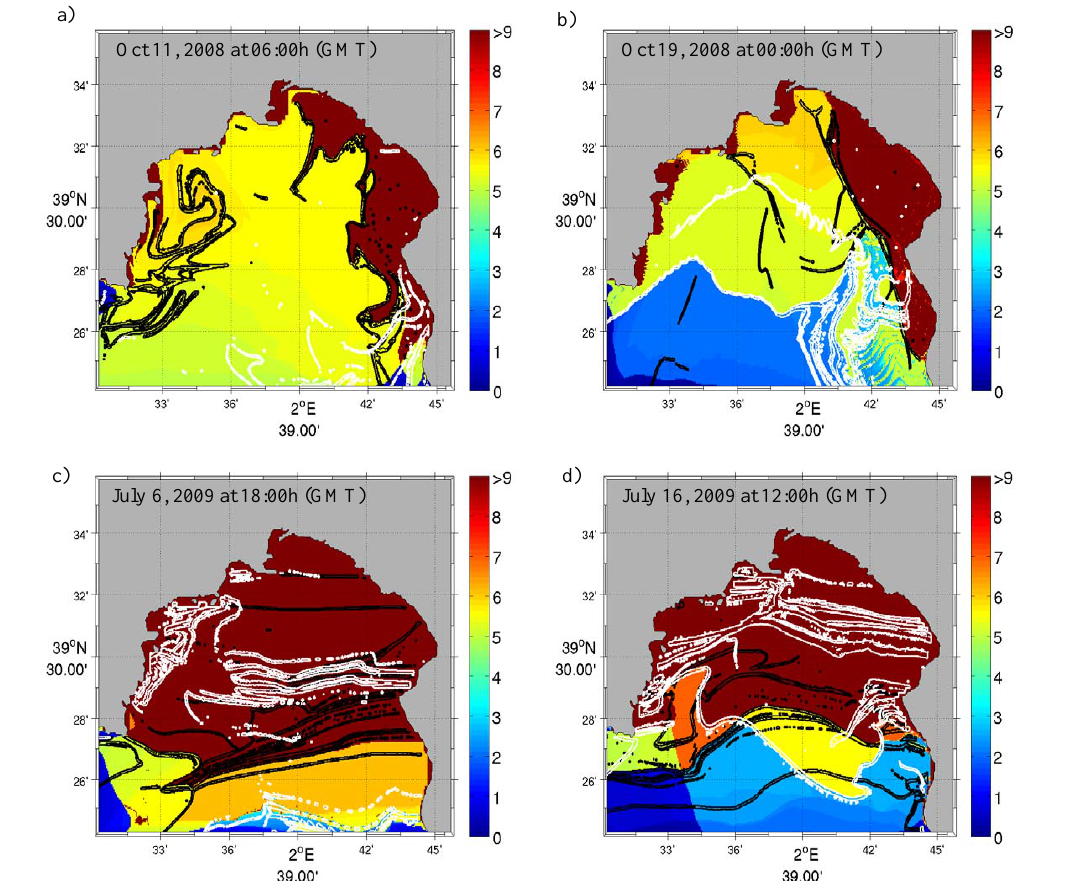
Fig. 7. Lines are the locations of top values of FSLE (greater than 0 . 5day − 1 in October and greater than 1 . 5day − 1 in July). Backward FSLE lines are colored in black and forward FSLEs in white. They are superimposed on spatial distributions of residence times in the Bay of Palma for different dates. The color bars give the residence times in days. (a) and (b) correspond to two different days in October, and (c) and (d) in